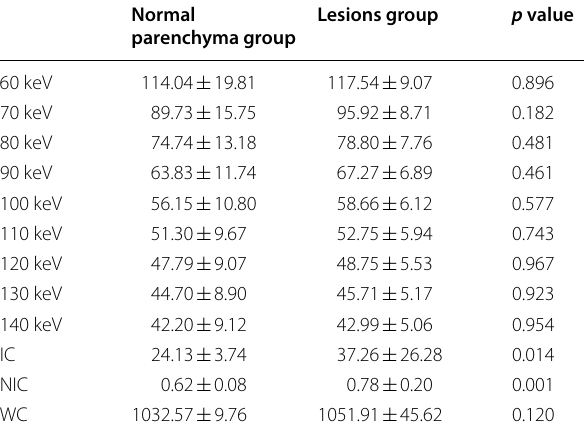
Table 6 Comparison of CT values of each single energy keV and IC, WC and NIC values in the venous phase between normal pancreatic parenchyma group and the lesions group Normal Lesions group p parenchyma group